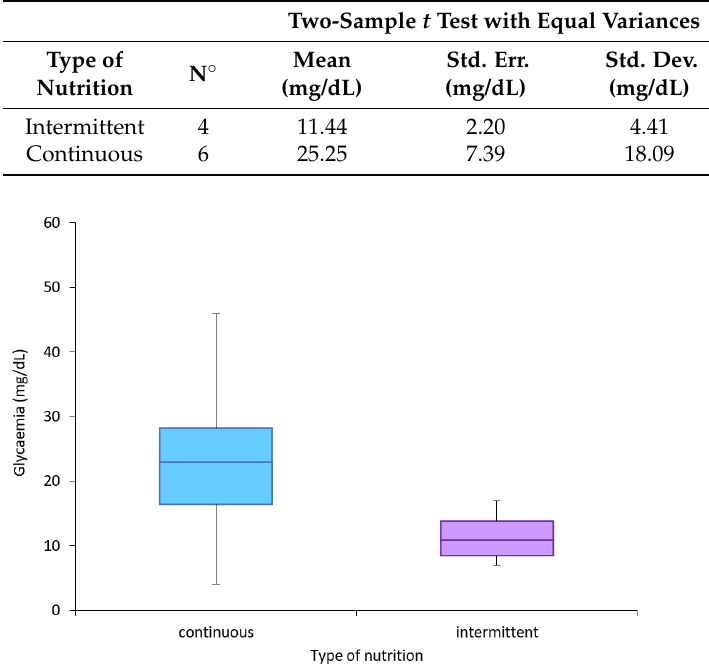
Figure 2. Median, minimum, and maximum MAGE value for each group.